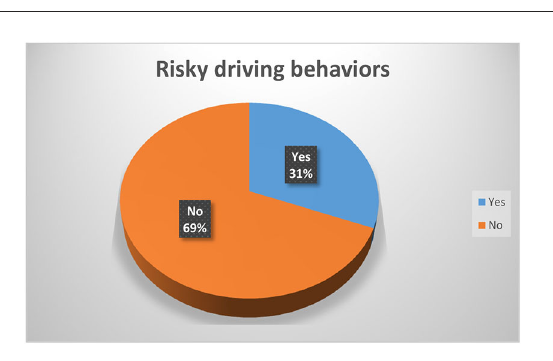
FIGURE1 Risky driving behaviors among drivers in Dilla Town, Gedeo Zone, Southern Ethiopia, 2021 (n = 316).